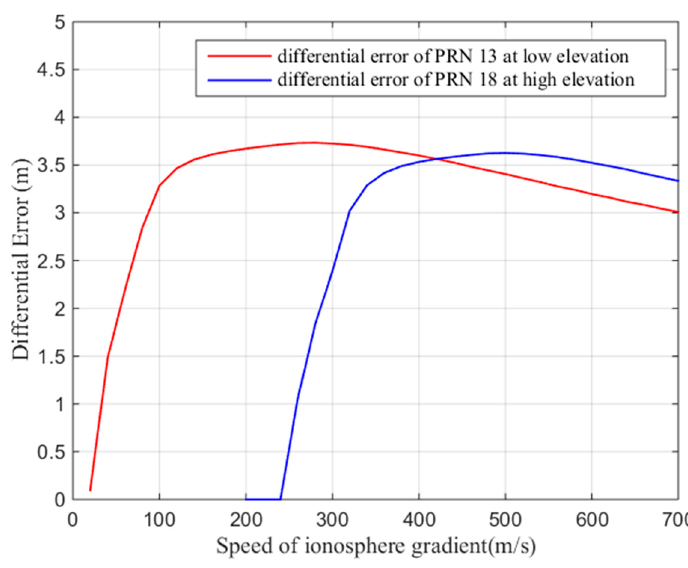
Figure 22. Maximum differential error vs. ionospheric gradient speed.